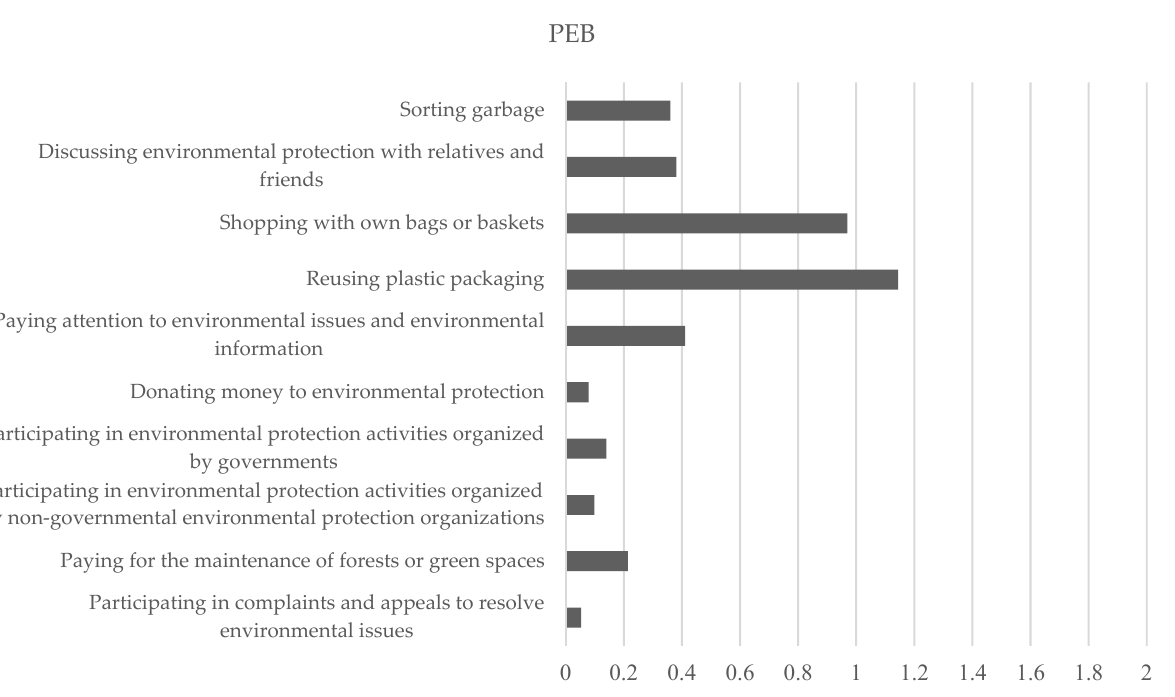
Figure 2. The pro-environmental behavior (PEB) of rural residents.